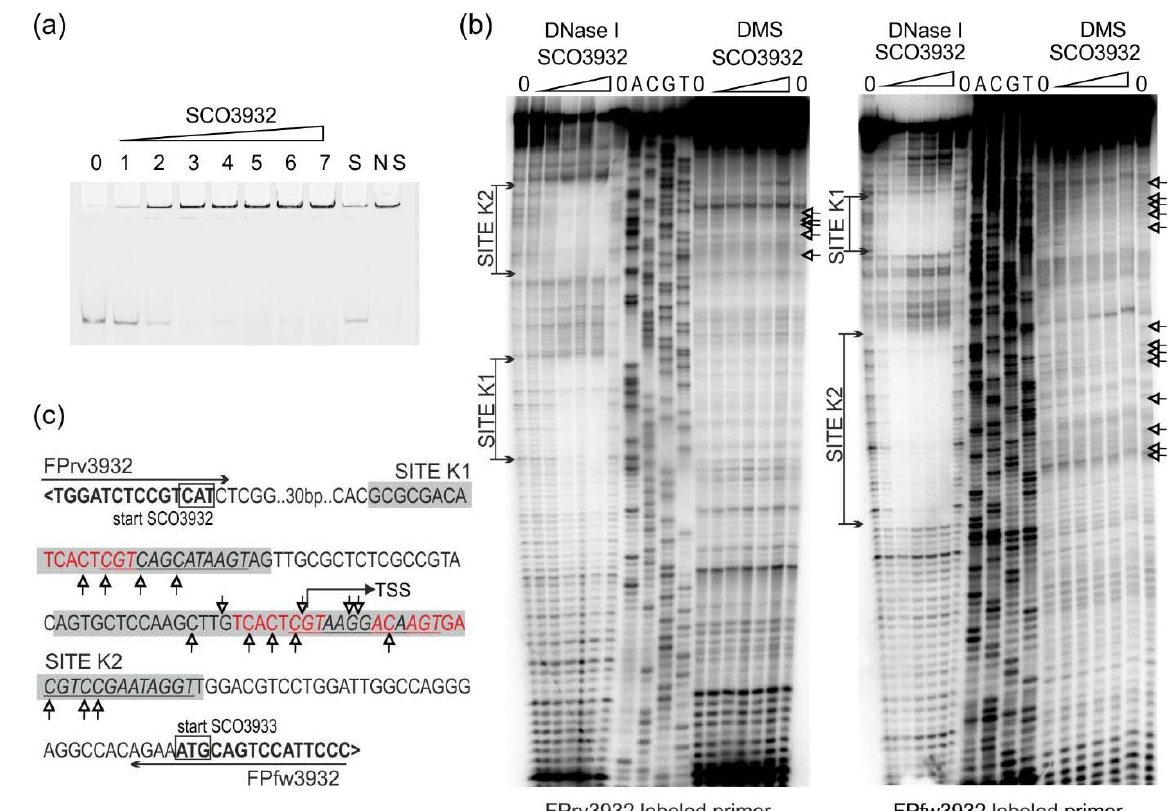
Figure 1. Binding of SCO3932 protein to the intergenic region between SCO3932 and SCO3933 genes. ( a ) Electrophoretic mobility shift assay with p3932/3933 fragment. Lanes 0–7 contain 0, 0.9, 1.8, 9.4, 18, 28, 47 and 94 nM SCO3932 protein, respectively. Lanes S and NS contain ten-fold excess of the specific and nonspecific competitor DNA, respectively, and 94 nM SCO3932 protein; ( b ) DNase I and DMS footprinting of SCO3932 binding to SCO3932 and SCO3933 promoter region. The concentrations of SCO3932 protein used were 0, 50, 100, 200, 400, 800, 0 nM in the consecutive lines. Lanes G, A, T, C correspond to the sequence ladder generated with the labeled primer. The regions protected from cleavage by DNase I are indicated (sites K1, K2). On DMS footprint guanines protected from cleavage are marked with small arrows; ( c ) DNA sequence of the SCO3932 and SCO3933 promoter region. Primers are marked with horizontal arrows. Coding sequences are in bold, and gene orientation is shown with <, >. Translational start codons are marked with boxes. Bent arrow denotes transcriptional start site (TSS) according to Jeong et al., 2016 [25]. The sequences protected by SCO3932 from cleavage (sites K1, K2) are indicated by the shaded boxes. Protected guanines are marked with small arrows. Sequence repeats (with one mismatch) are in red. Sequence corresponding to the common motif identified by MEME (see Figure 4) is underlined and in italic.